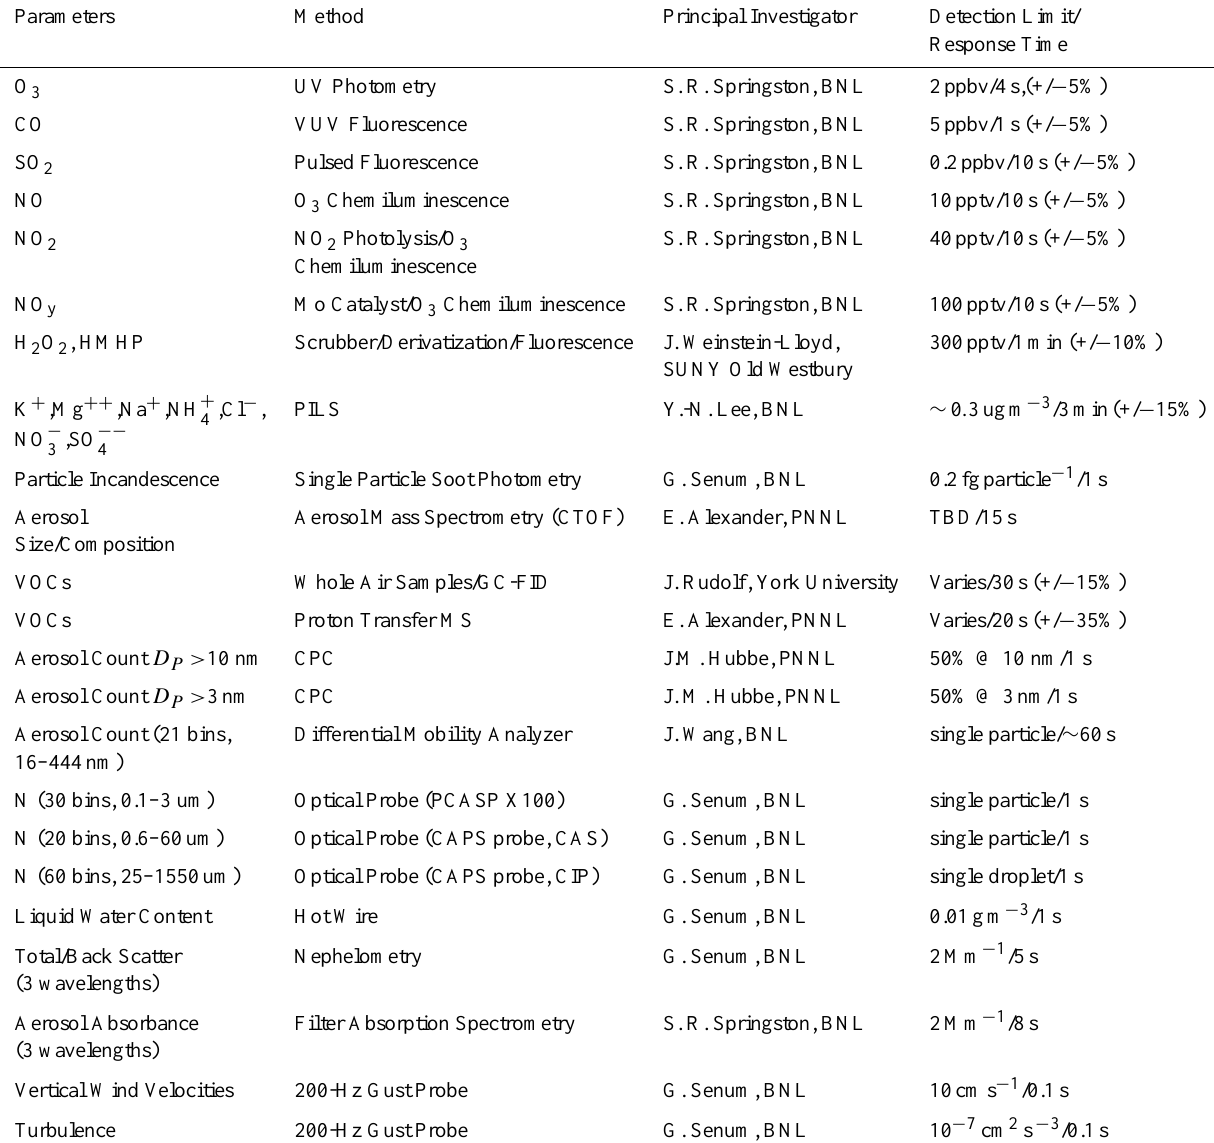
Table 6. Scientific payload of the G-1